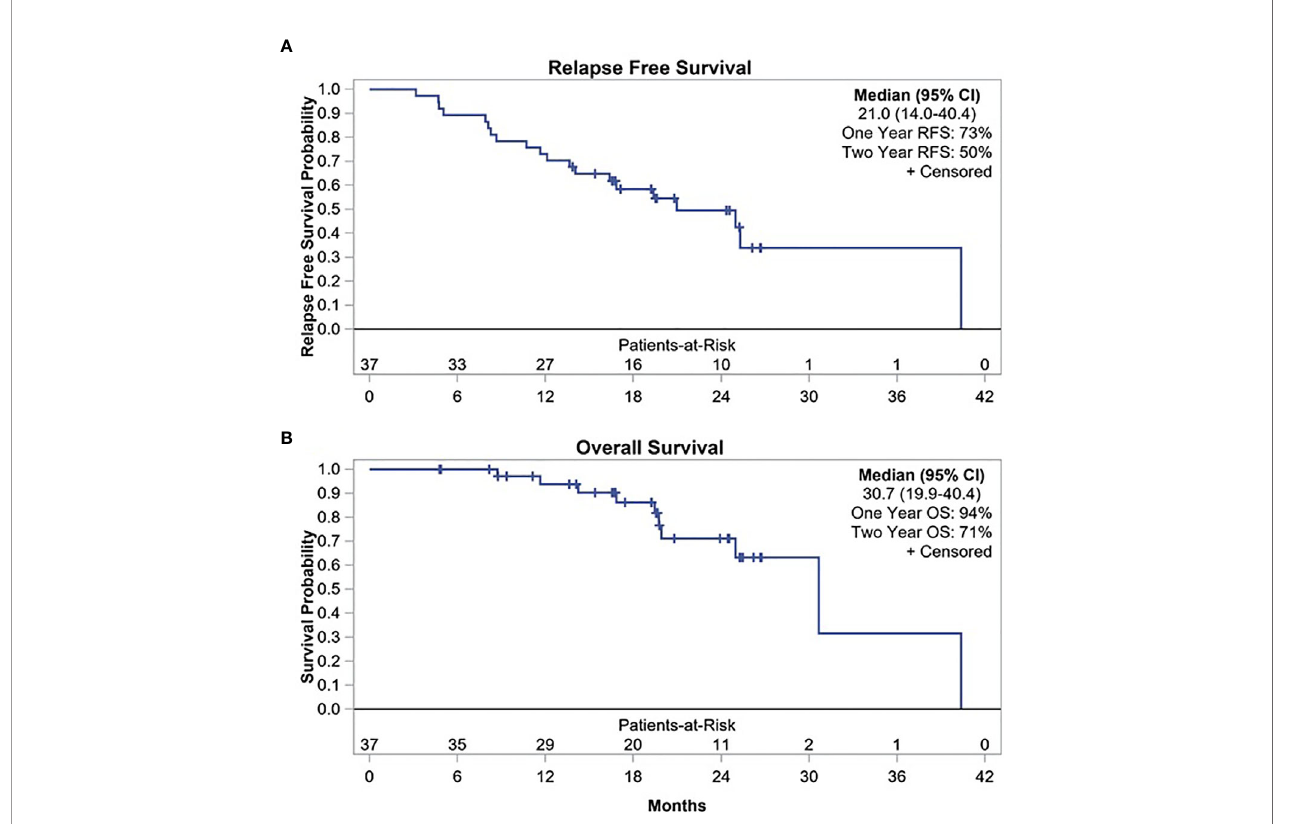
FIGURE 1 | (A) Relapse free survival, (B) Overall survival with